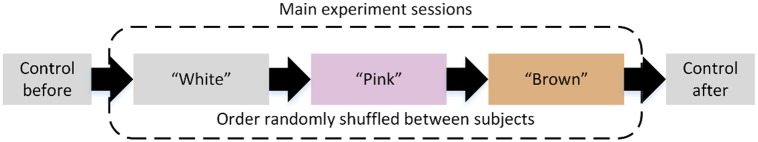
Experimental protocol.